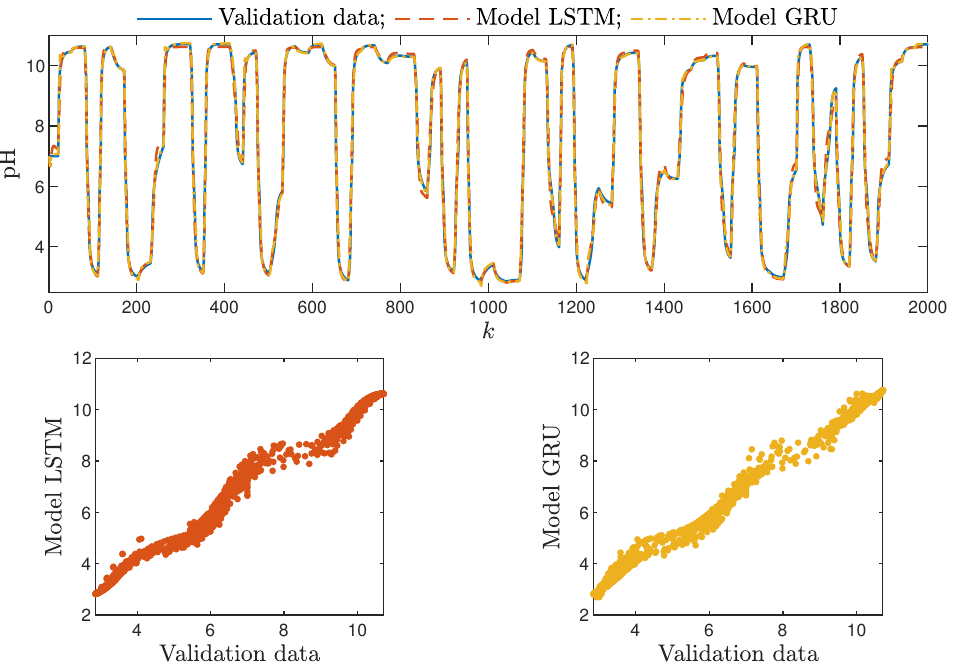
Figure 12. The neutralisation reactor: the validation dataset vs. the output of the LSTM and GRU models for n N = 5, n A = n B =